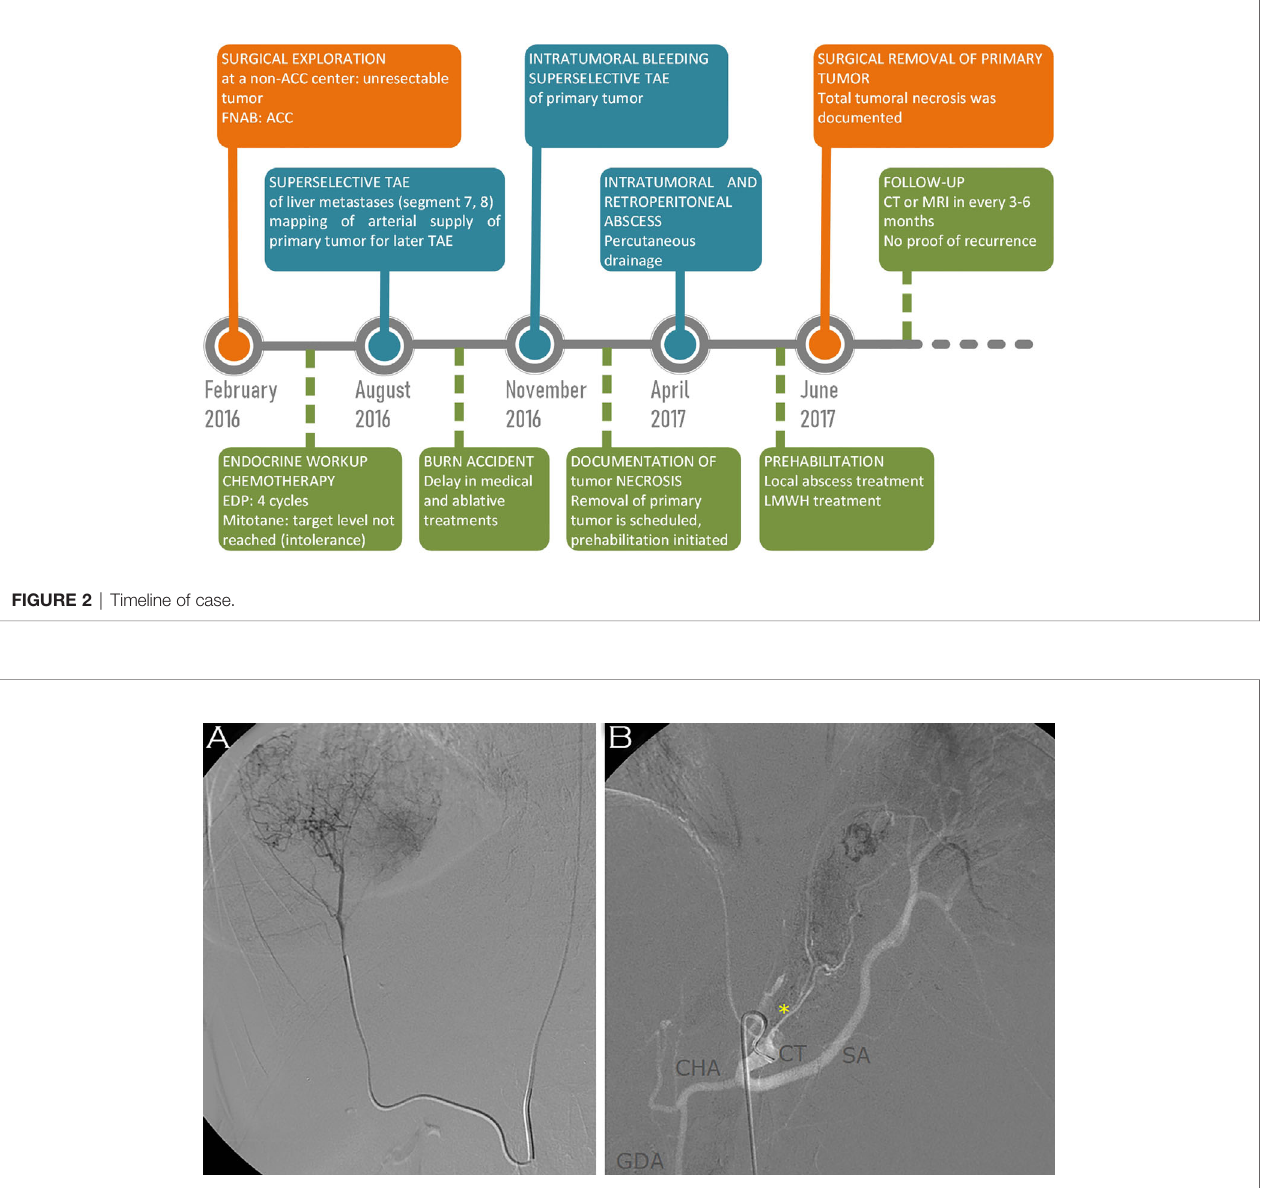
FIGURE 3 | Embolization of the S8 tumor through the right replaced hepatic artery was achieved with 0.1mm PVA particles (A) . Embolization of the primary tumor through the left inferior phrenic artery was performed by 0.2mm PVA particles (B) . CT, celiac trunk; SA, splenic artery; CHA, common hepatic artery; GDA, gastroduodenal artery; *, dominant suprarenal artery from left inferior phrenic